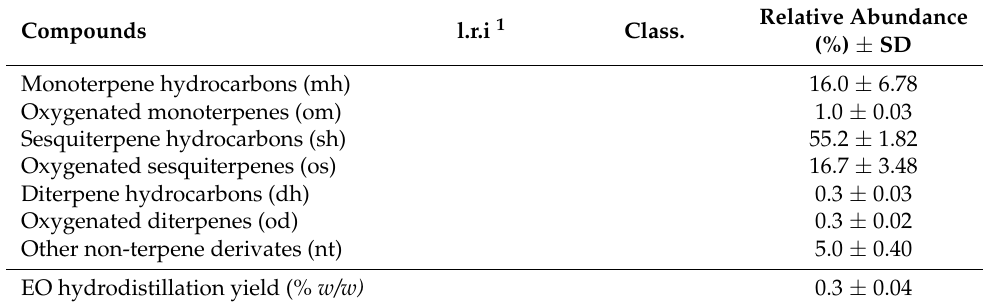
Table 3. Chemical composition of the headspaces of Humulus lupulus L. Cascade cones and Hibiscus rosa-sinensis L. flowers. Compounds l.r.i. 1 Class.